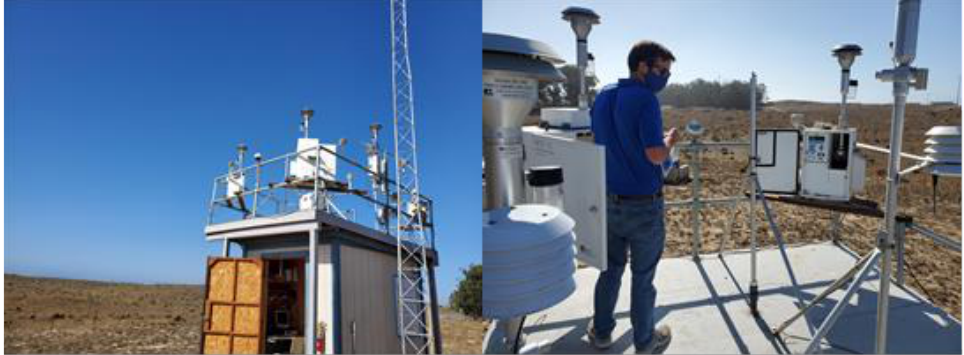
Figure 2. The Partisol samplers and BAM 1020 monitors at the CDF sampling site. All sampler inlets (Partisols and BAMs) were approximately 4.0 m above ground level (Photo credit, David Cardiel).